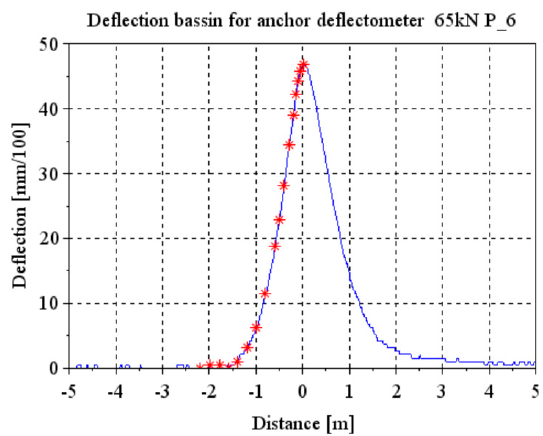
Figure 21a–e represent the fitted deflection basins obtained with Alize, and compare them with the measured deflections. On each figure, the green lines represent the measured values, and the red lines the adjusted calculated deflection curves. For the two geophones and the two accelerometers, a very good fit is obtained between the measured and calculated deflections. For the anchored deflectometer, however, a larger difference between the measured and calculated basin is obtained after the optimization. Figure 20. Deflection points selected on the deflection basin for the back calculation with Alize.